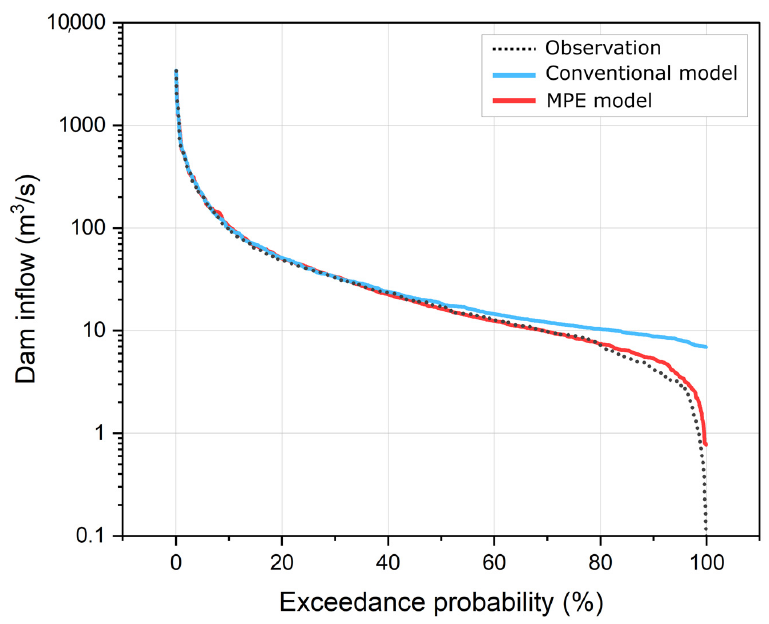
Figure 8. FDCs of observed inflow and inflow predicted by both models during the whole test period.